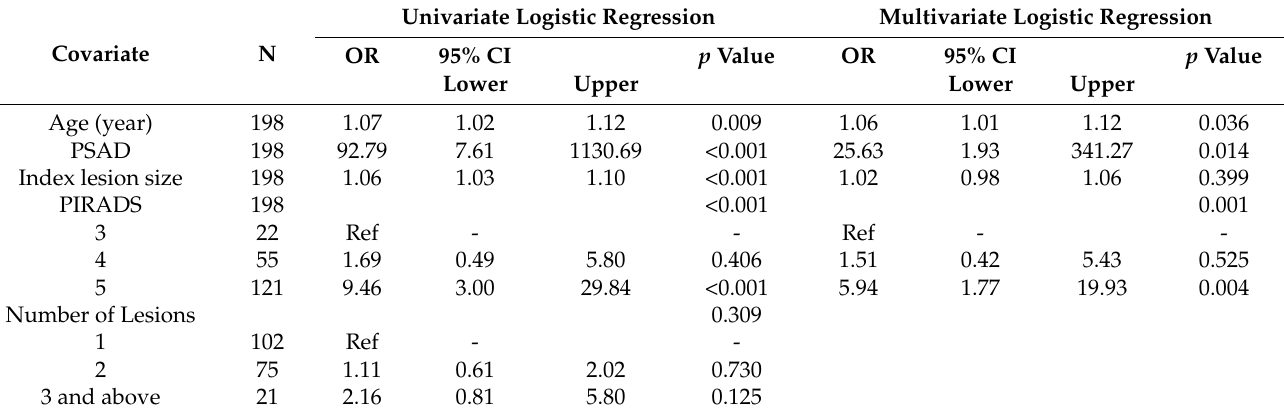
Table 2. Univariate and multivariate logistic regression analysis.